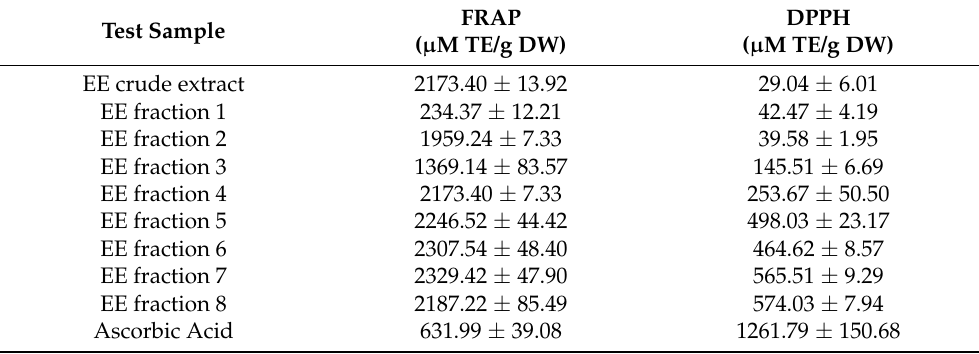
Table 3. Antioxidant properties of the crude extract and fractions (F1–F8) of Erismadelphus exsul. FRAP Test Sample ( µ M TE/g